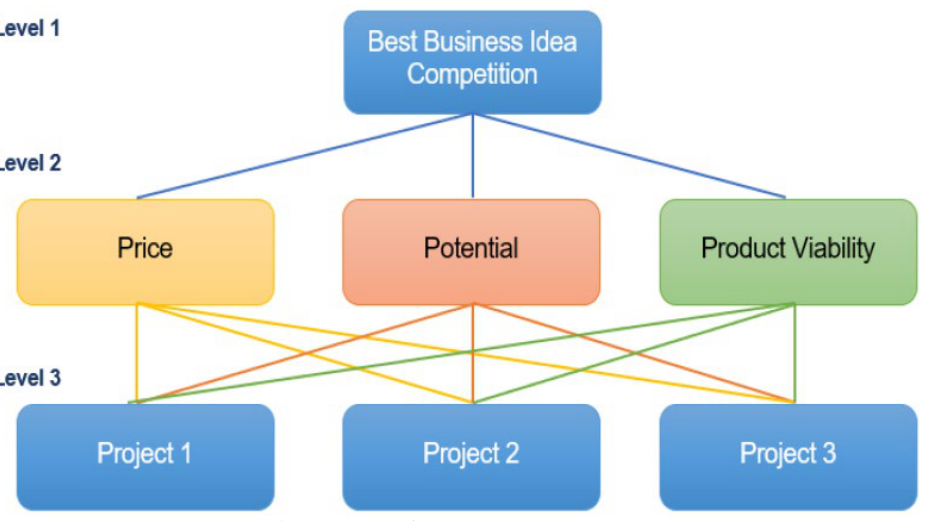
Figure 2. Structure of the AHP